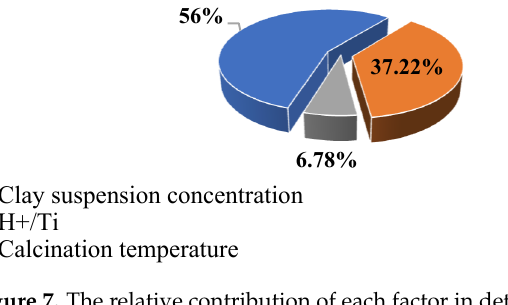
Figure 7. The relative contribution of each factor in determining the specific surface area of Ti-PILC.